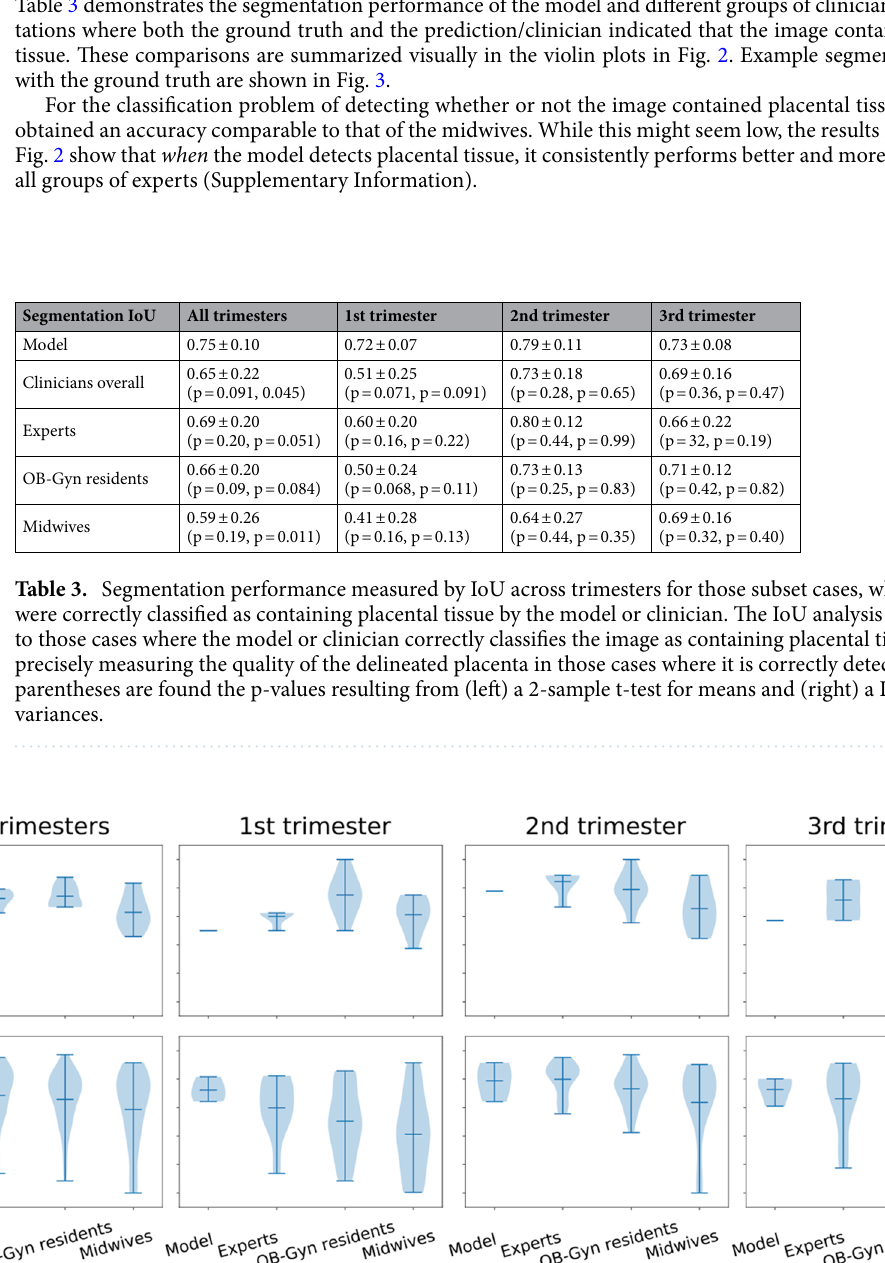
Table 3 demonstrates the segmentation performance of the model and different groups of clinicians on segmen- tations where both the ground truth and the prediction/clinician indicated that the image contained placental